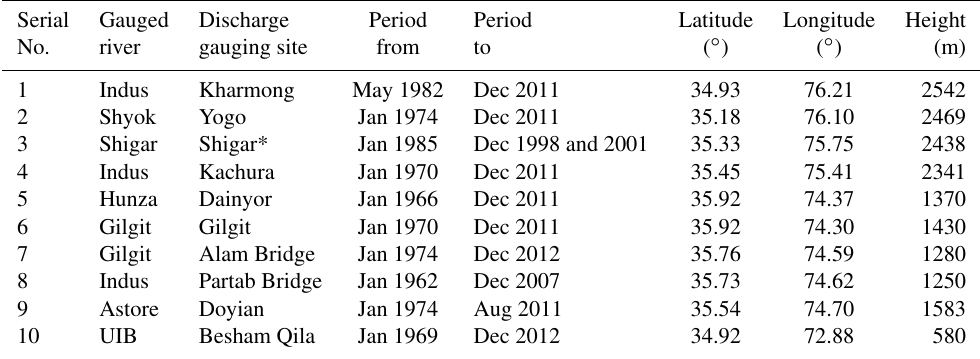
Table 3. SWHP WAPDA stream flow gauges given in the downstream order along with their characteristics and their periods of record analyzed. Asterisk indicates gauge is not operational after 2001. Serial Gauged Period